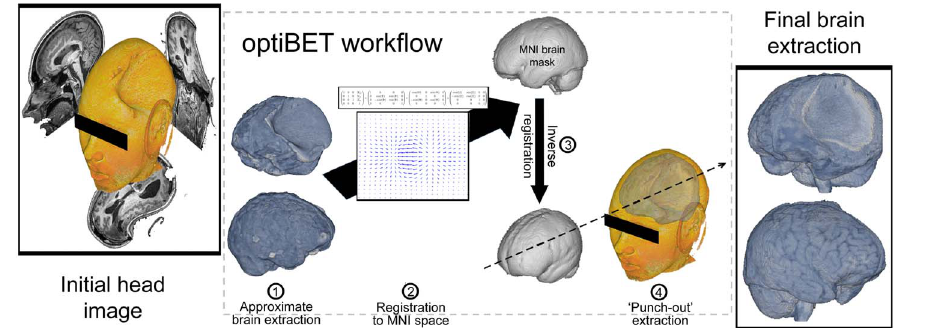
Fig. 4. OptiBET workflow. Visual representation of the optiBET script workflow: (1) initial approximate brain extraction is performed using BET (and options ‘B’ and ‘f’, as suggested previously [5]); (2) sequential application of a linear and non-linear transformation from native space to MNI template space; (3) back- projection of a standard brain-only mask from MNI to native space; and (4) mask-out brain